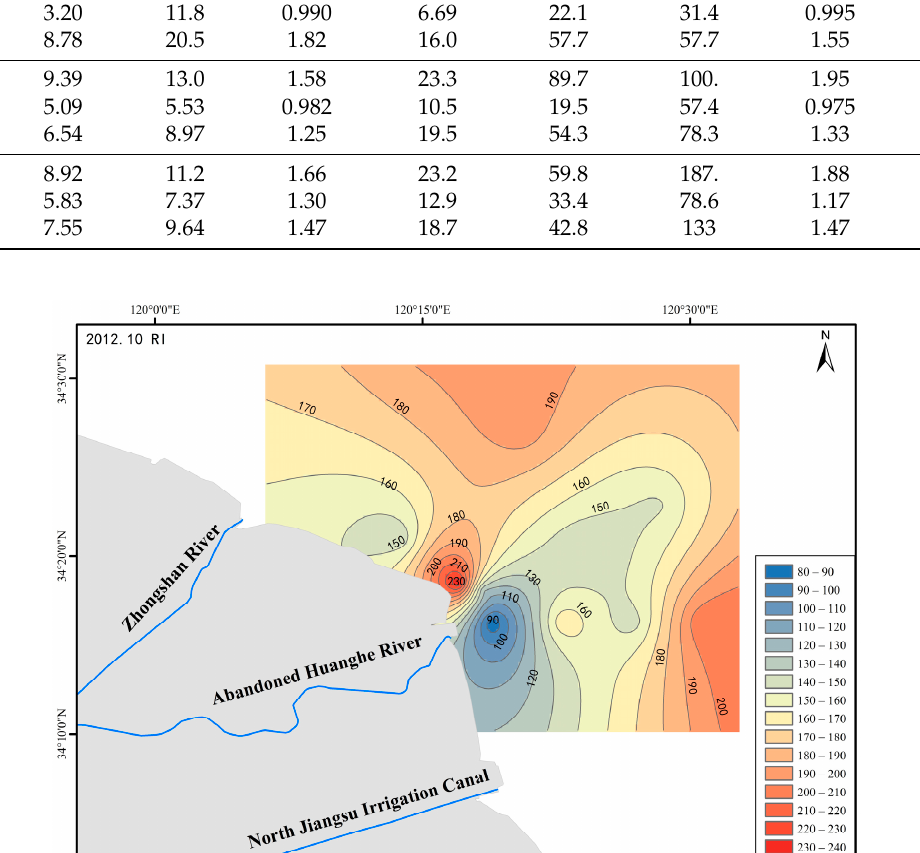
Figure 2. Distribution map of the comprehensive potential ecological risk index in 2012.